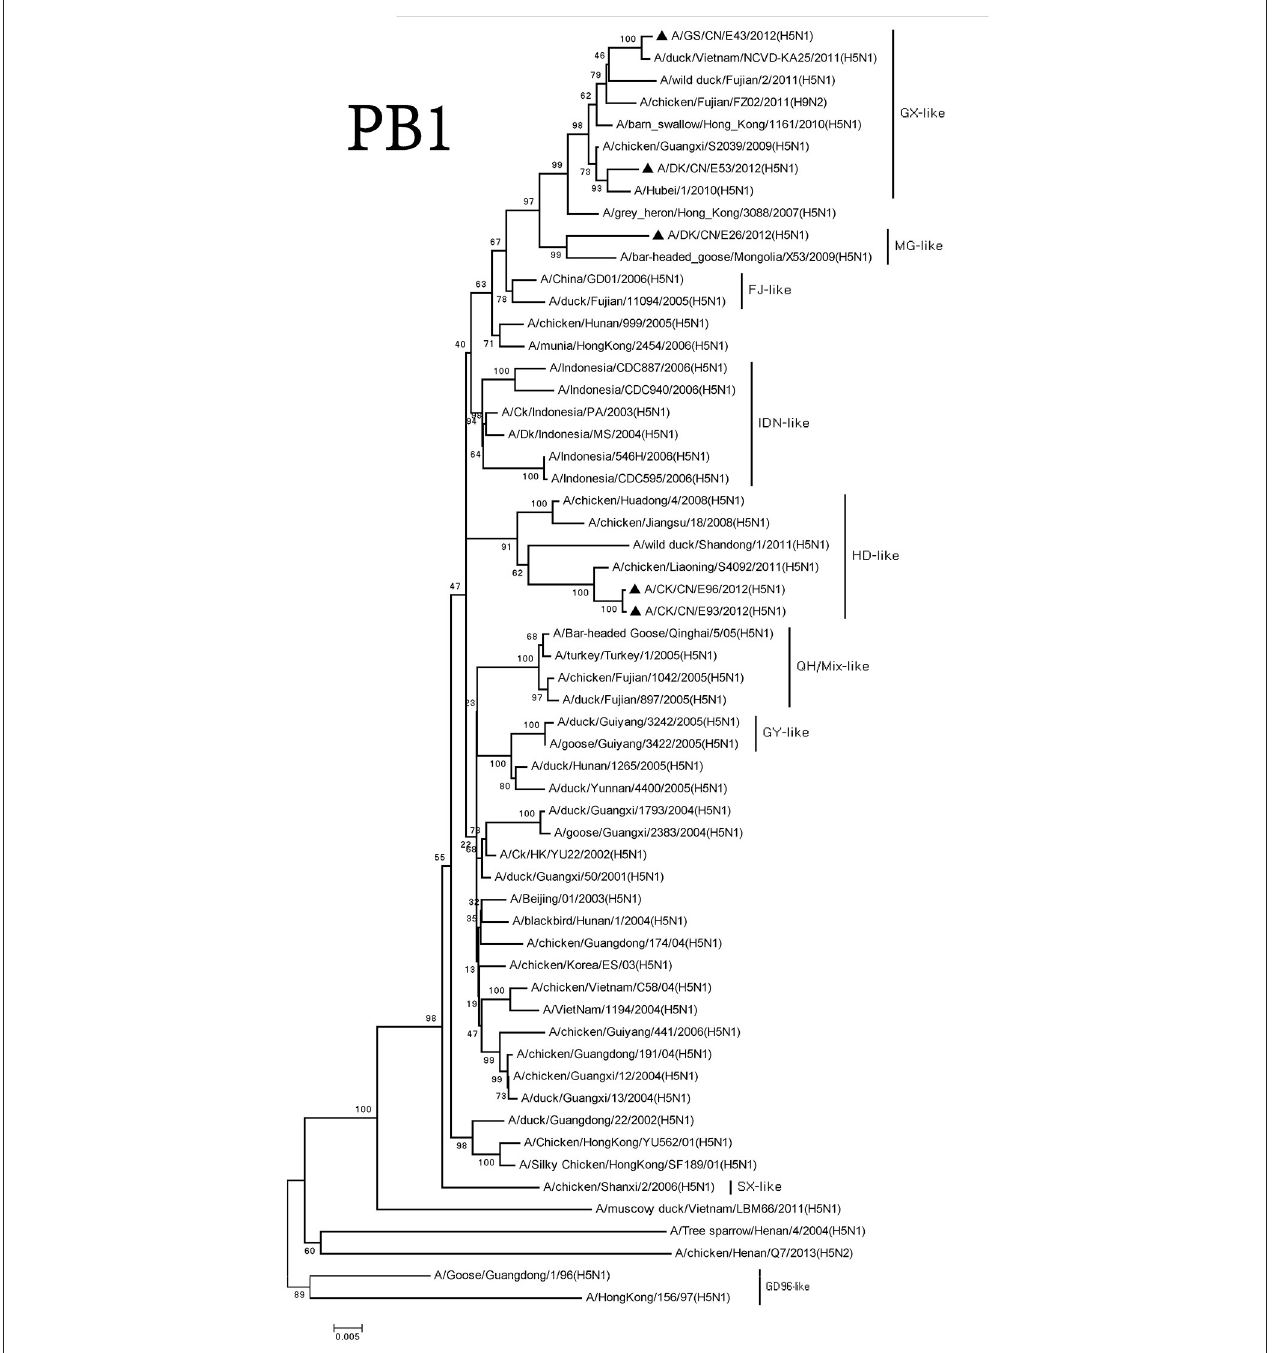
FIGURE 4 | Phylogenetic analysis of PB1. PB1: nt 25–2,298. Except our isolate, other virus sequences were downloaded from GenBank. QH, Qinghai; VN, Vietnam; IDN, Indonesia; GY, Guiyang; MG, Mongolia; GX, Guangxi; HD, Huadong; SX, Shanxi.